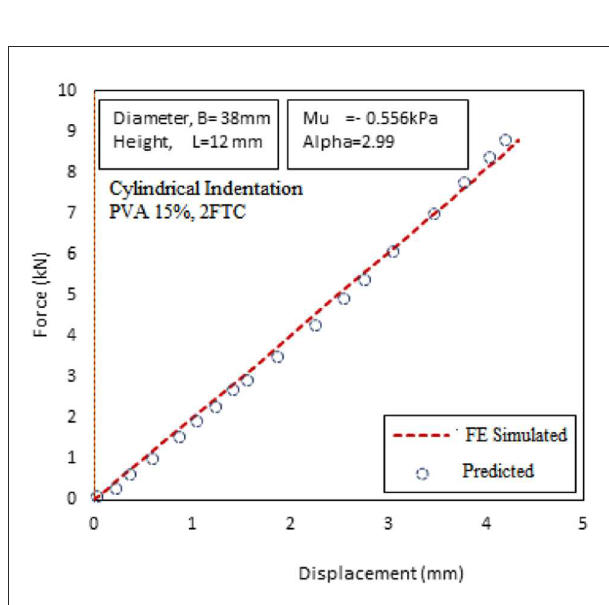
FIGURE9 Load vs. displacement graph for PVA-C sample with finite thickness and 15% concentration.